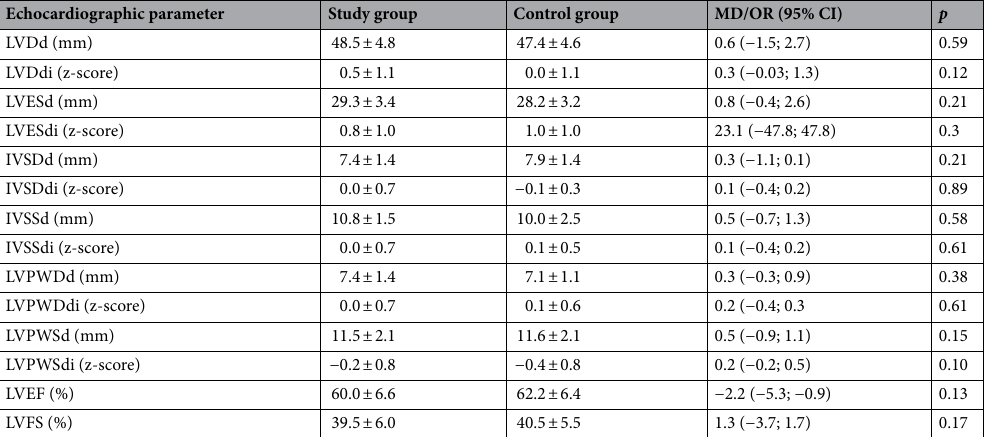
Table 2. Echocardiographic parameters of the systolic function in the study and control group. LVDd left ventricular end-diastolic dimension, LVDdi left ventricular end-diastolic dimension index, LVESd left ventricular end-systolic dimension, LVESDi left ventricular end-systolic dimension index, IVSDd interventricular septal diastolic diameter, IVSDd interventricular septal diastolic diameter index, IVSSd interventricular septal systolic diameter, IVSSd interventricular septal systolic diameter index, LVPWDd left ventricular posterior wall diastolic diameter, LVPWDd left ventricular posterior wall diastolic diameter index, LVPWSd left ventricular posterior wall systolic diameter, LVPWSd left ventricular posterior wall systolic diameter index, LVEF left ventricular ejection fraction, OR odds ratios, MD mean/median differences.